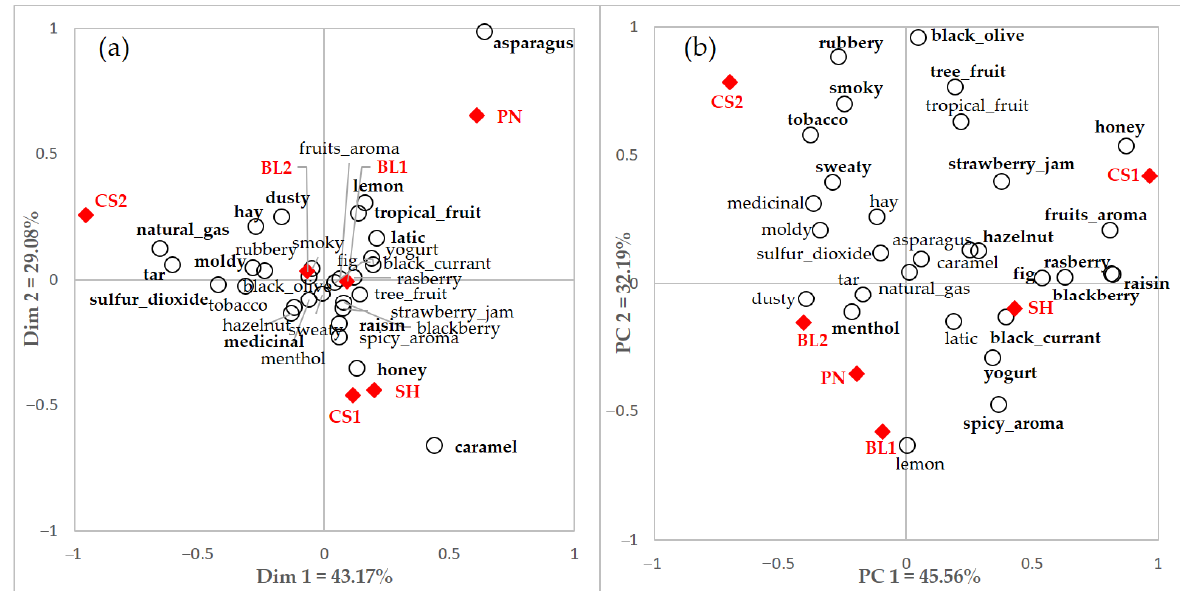
Figure 2. ( a ) Correspondence analysis (CA) and ( b ) principal component analysis (PCA) of total consumer data with integrated significant terms ( n = 30) by CATA and rating of total consumers. Filled diamonds indicate a red wine sample and empty circles indicate an attribute. Terms in bold indicate significant differences shown among samples.